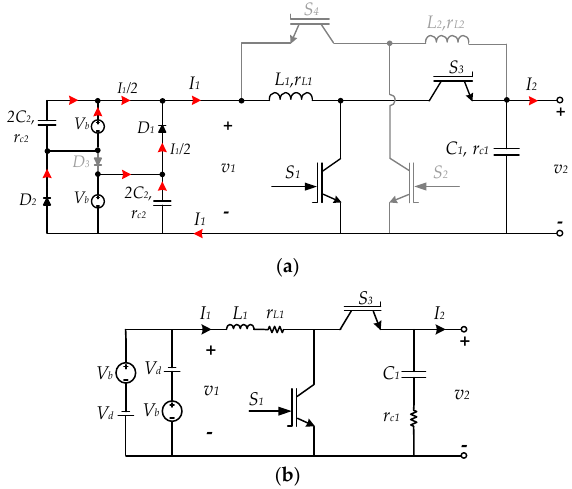
Figure 4. Discharge mode circuit. ( a ) Current flow diagram; ( b ) equivalent circuit.